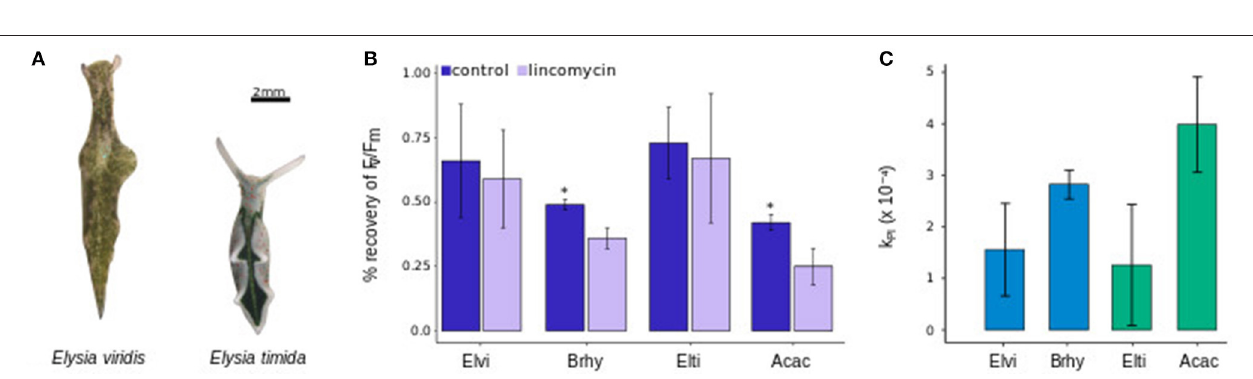
FIGURE 5 | Length measurements of E. viridis (A) and E. timida (B) during starvation and under darkness (black circles), 45 µ mol photons m − 2 s − 1 (green circles) and 250 µ mol photons m − 2 s − 1 (orange circles). Please note that each specimen differed in absolute length, so we used the relative length as more comparable measure. All measurements were performed in biological triplicates and error bars show the standard deviation.